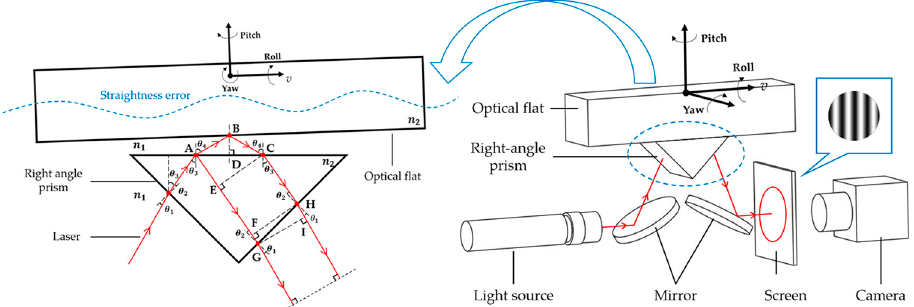
Figure 2. Schematic drawing of the film interference module.